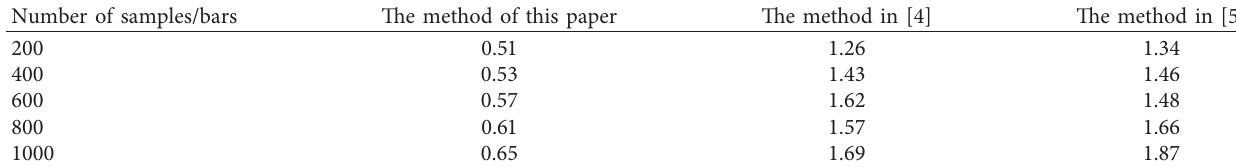
Table 1: Time cost of data integration of sample preschool language education resources by different methods (s). Number of